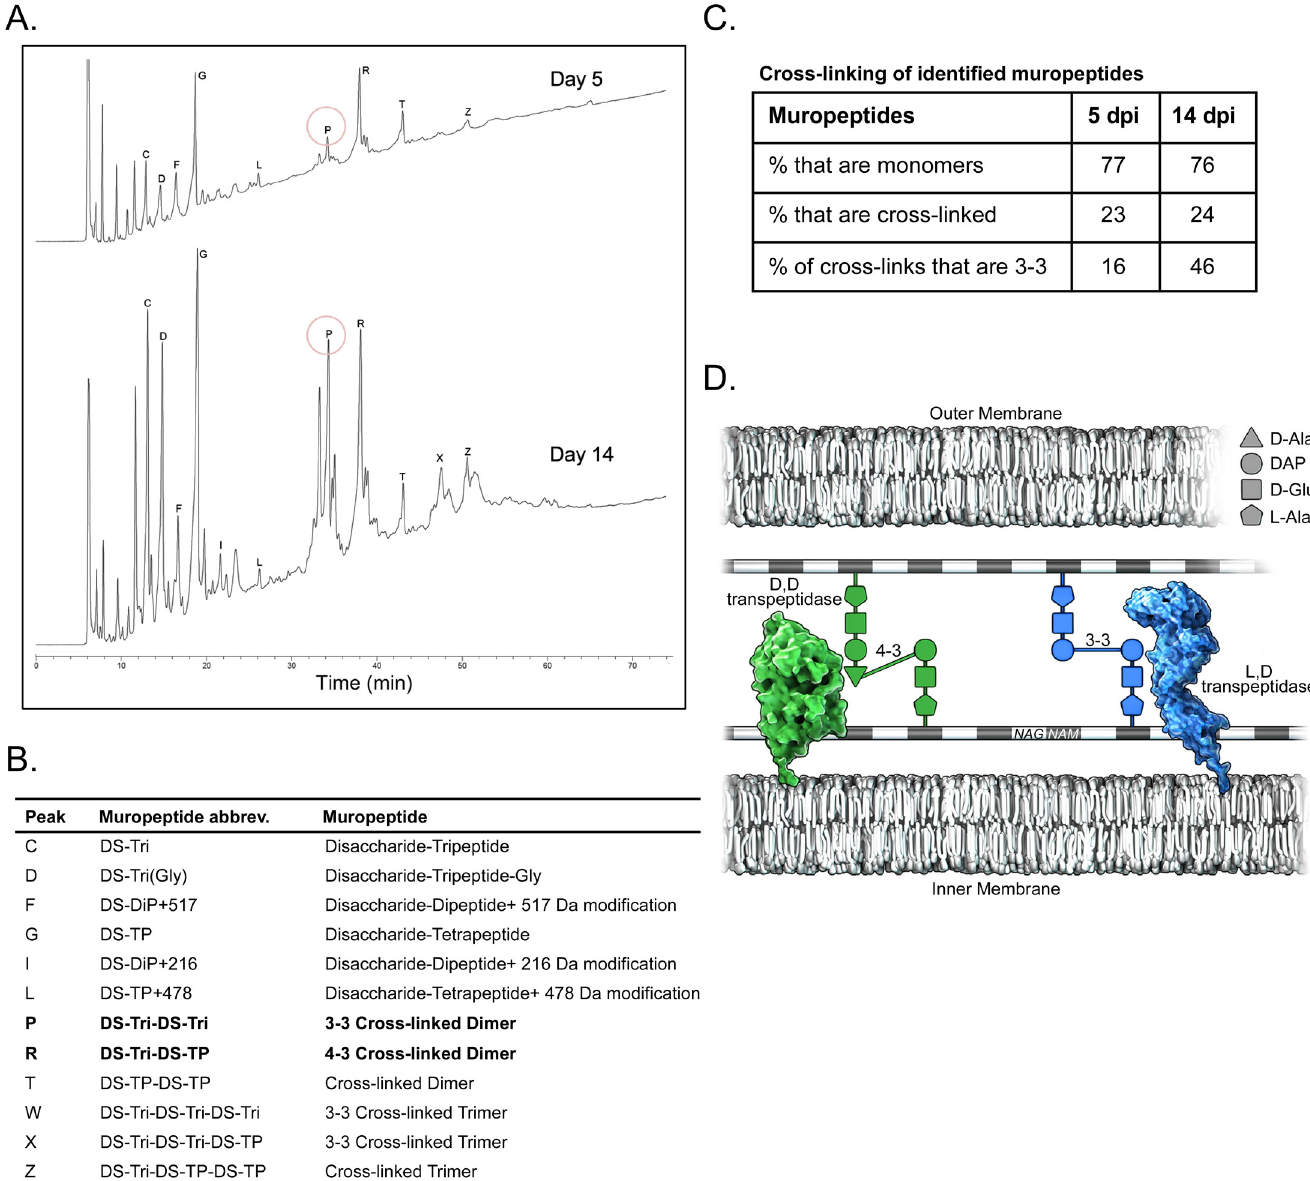
Fig 6. Muropeptide analysis of C . burnetii peptidoglycan. (A) HPLC elution profiles of muropeptides of LCV and SCV purified from Vero cells at 5 and 14 days post-infection (dpi), respectively (B) Muropeptides identified by MS and corresponding HPLC peaks in panel (A). (C) Molar percentage of muropeptides in monomer or cross-linked forms. The percentage of 3 – 3 cross-linked forms is also shown. (D) Schematic of peptidoglycan containing classical 4 – 3 and non-classical 3 – 3 cross-links that correspond to peaks R and P, respectively in panel (A). Unlinked stem peptides that are anchored to NAM residues have been removed for clarity. Abbreviations: NAG, N -acetylglucosamine; NAM, N -acetylmuramic acid; DAP,